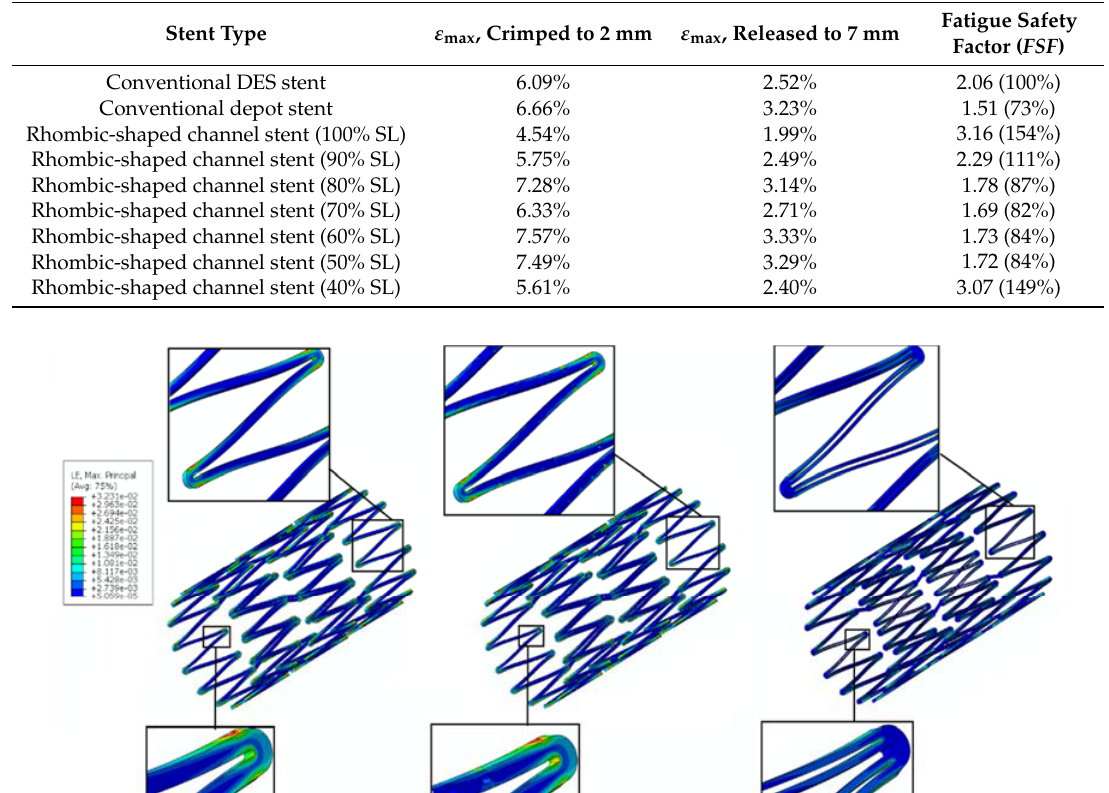
Table 2. Maximum strain and fatigue safety factor as a function of narrowed strut width.